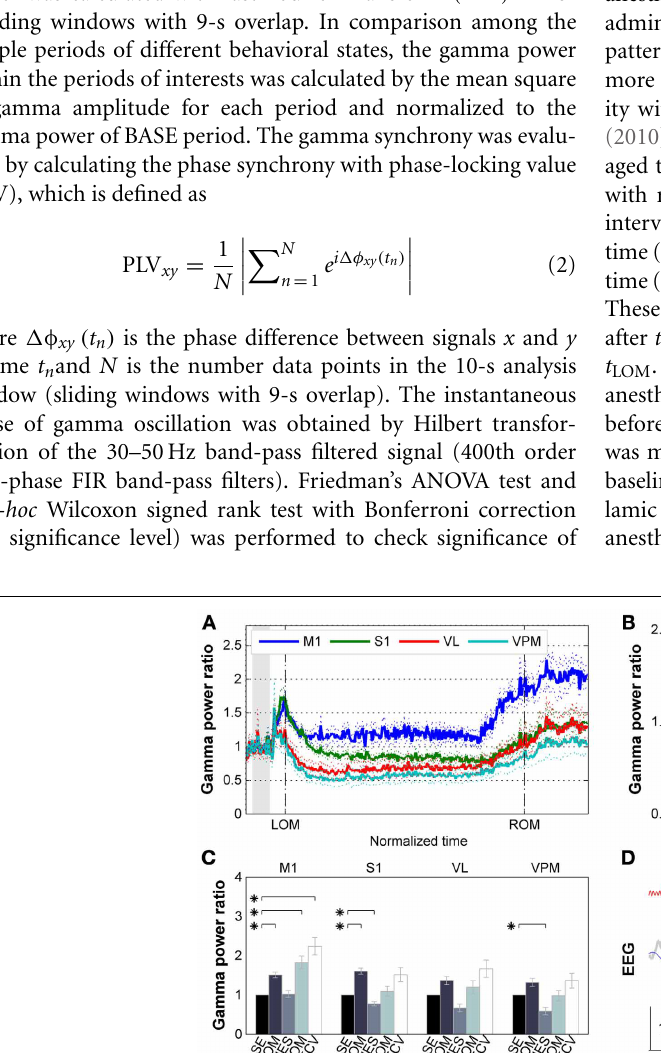
FIGURE 2 | Effects of ketamine/xylazine on gamma power. (A) Subject-averaged temporal change of gamma (30–50Hz) power with respect to normalized time window between t LOM and t ROM (dashed vertical lines, 33 . 23 ± 8 . 34min from t LOM to t ROM , mean ± SD ). Gray shade indicates distribution of relative positions of t ADM in reference to t LOM . Dotted lines for s.e.m. Each power was baseline corrected. (B) Subject-averaged change of gamma power in M1 with respect to anesthetic concentration, (C) estimated with three-compartment anesthetic concentration model. Gray whiskers for s.e.m. Zero anesthetic concentration corresponds to t ADM and arrows indicate flow of time. Blue and green shaded patches indicate the distribution of t LOM and t ROM with